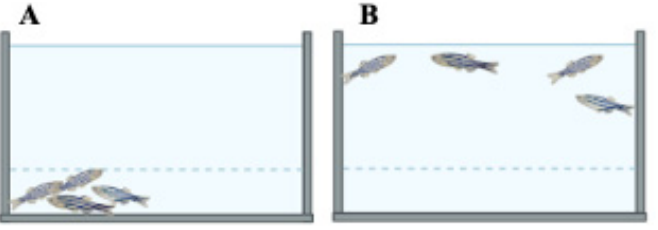
Figure 10. Shoaling test in zebrafish. ( A ) Normal shoaling behaviour; ( B ) disrupted shoaling behaviour. Created with Biorender.com.